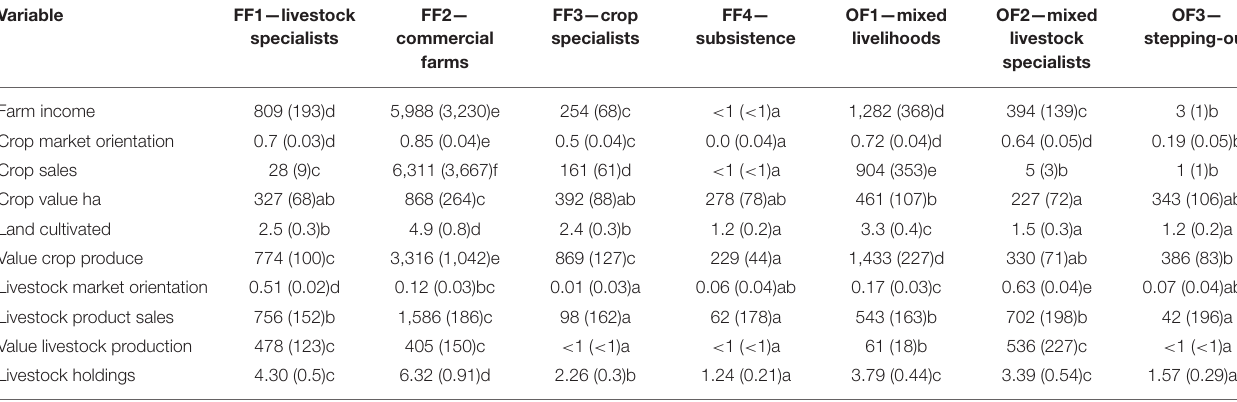
TABLE 3 | Estimated marginal means for farm production variables of the different household livelihood strategy types # . Variable